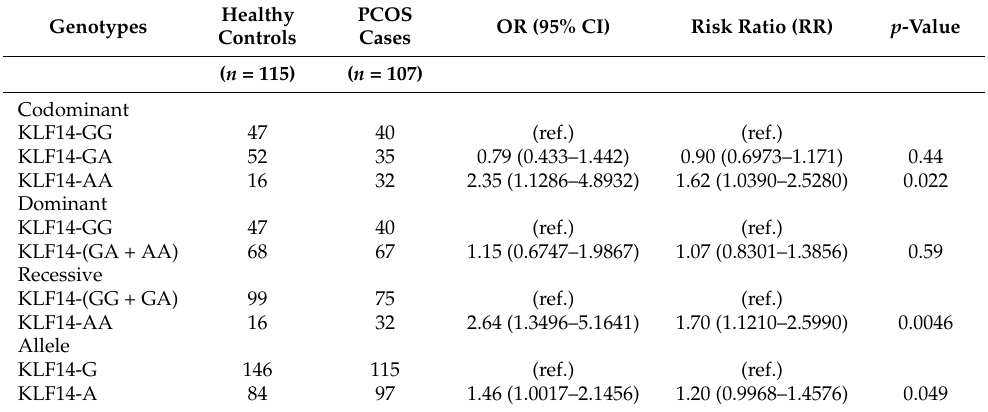
Table 4. Association of Krüppel-like factor 14 rs972283 G > A gene variation with PCOS